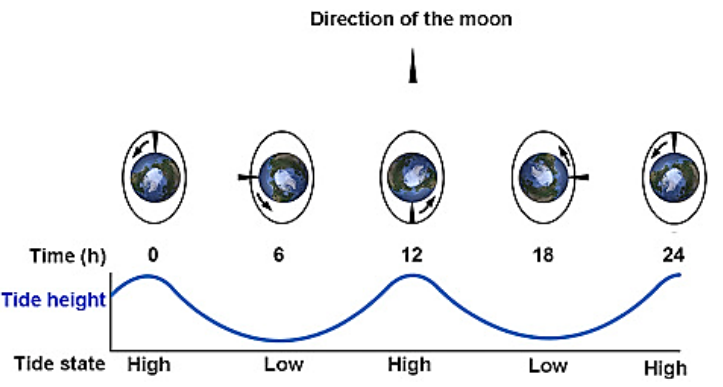
Figure 1. The influence of the moon on tidal genesis.